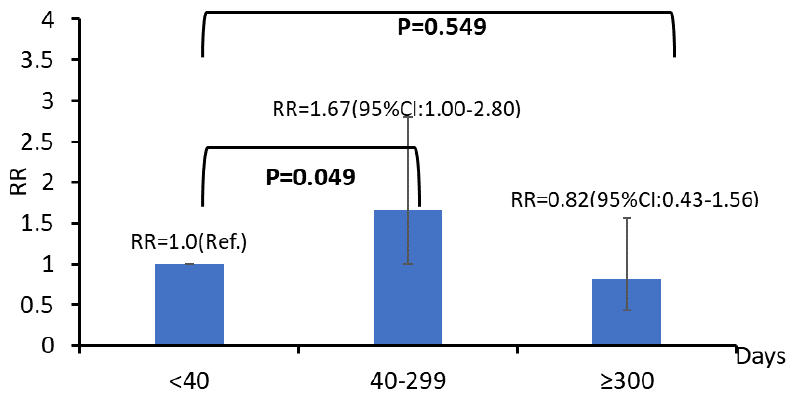
Figure 1. Relationship between the cumulative dose (days) of passive smoking exposure and cognitive impairment among non-smokers (ZJMPHS Program, Zhejiang, China). Adjusted for age, sex, ethnicity, body mass index, education, marital status, job type, family income, participation in group activities, smoking, alcohol consumption, tea consumption, physical exercise, and work. RR: relative risk; CI: confidence interval; ZJMPHS Program: Zhejiang Major Public Health Surveillance Program.